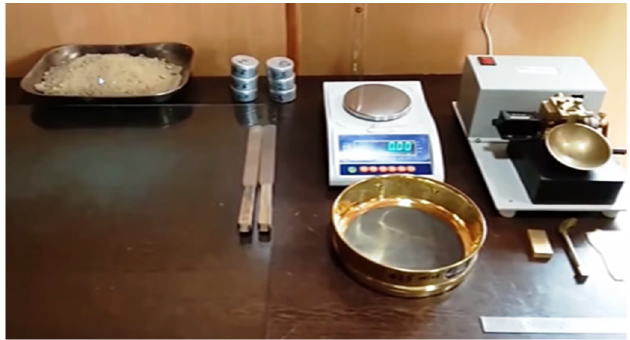
Figure 3. Determination of LL and PL with a Casagrande apparatus.